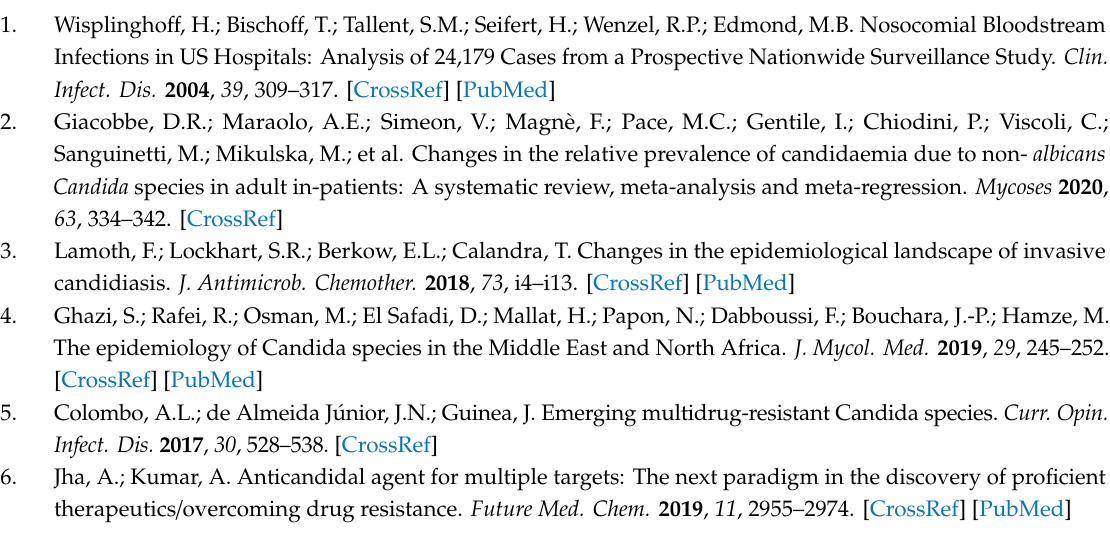
Table S1: Main chemical components of EOs of selected Lamiaceae family plants; Table S2: Minimum Inhibitory Concentrations (MICs) of the EOs collected from 100 species of Lamiaceae